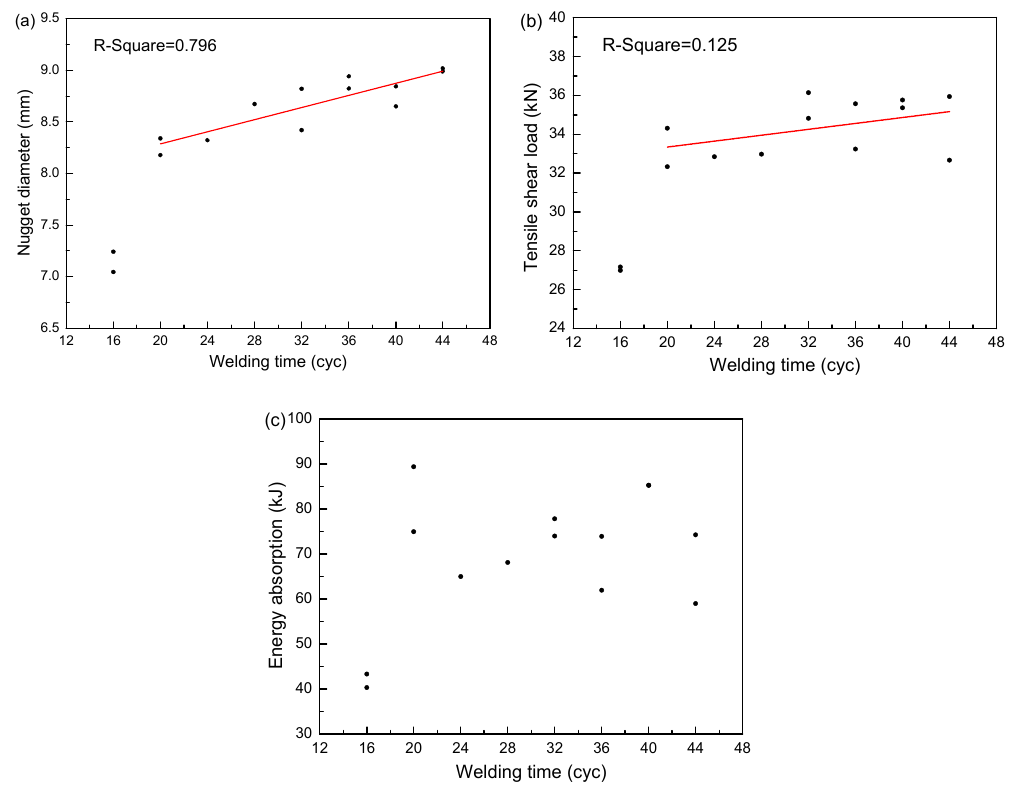
Figure 4. Effect of welding time: ( a ) Nugget diameter vs. welding time; ( b ) Tensile-shear load vs. welding time; ( c ) Energy absorption vs. welding time.